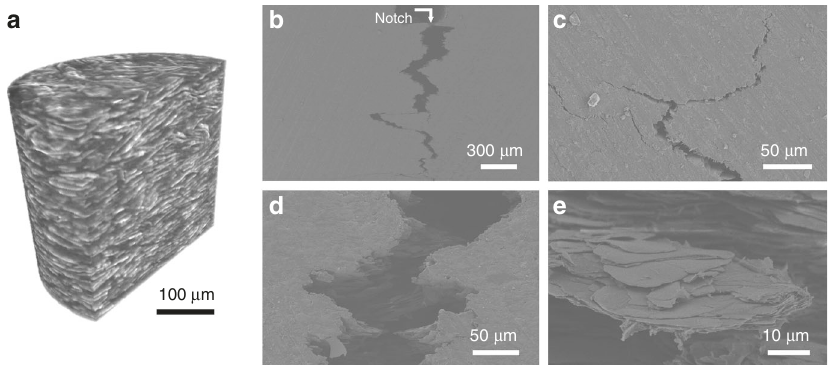
Fig. 3 Brick-and-mortar structure and multiscale extrinsic toughening mechanisms. a 3D reconstruction of the all-natural bioinspired structural material derived from X-ray microtomography. b Fracture surface of an all-natural bioinspired structural material sample that shows long-range crack de fl ection. c Crack de fl ection, branching, bridging, and multiple cracking towards the end of the crack path. d Pulling out of TiO 2 -mica microplatelets. e Details of the fracture surface showing TiO 2 -mica microplatelet ’ s pulling out, delamination, CNF bridging, and